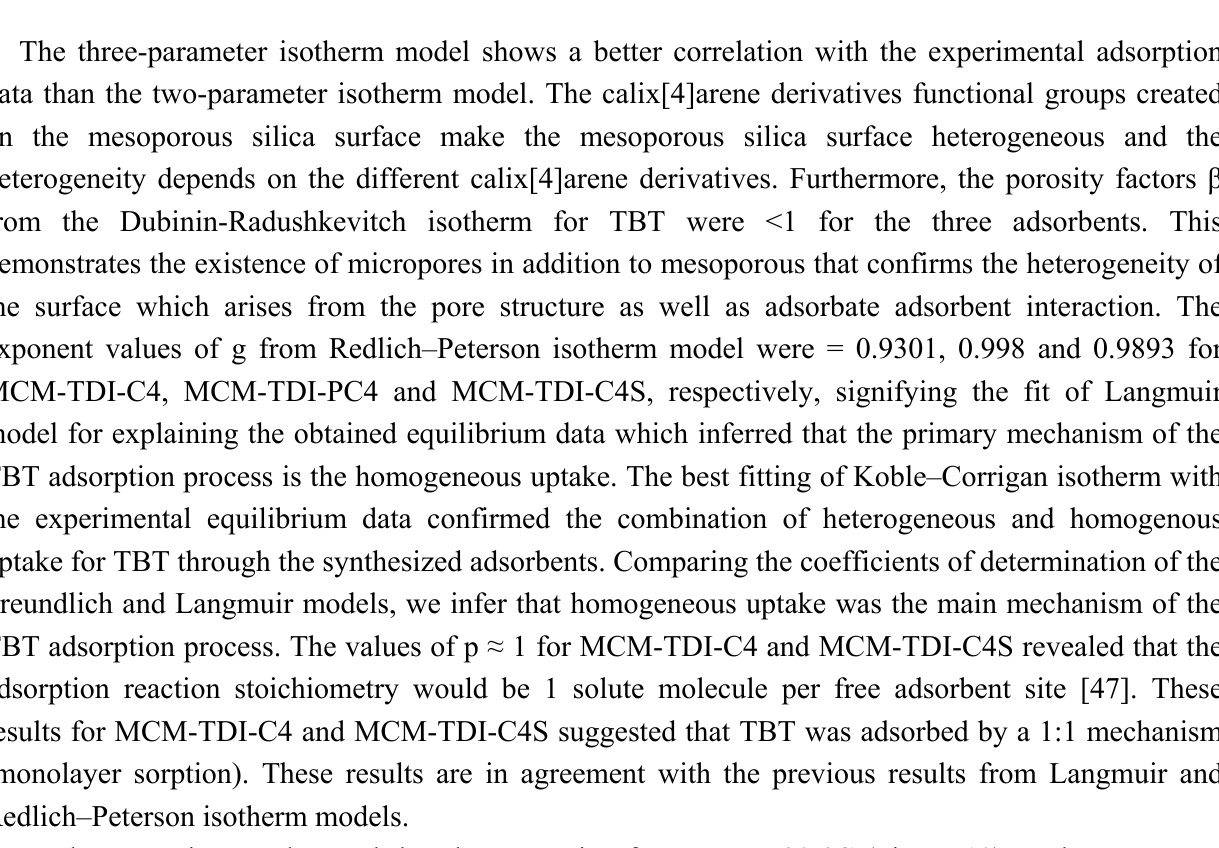
Figure 10. Values of R